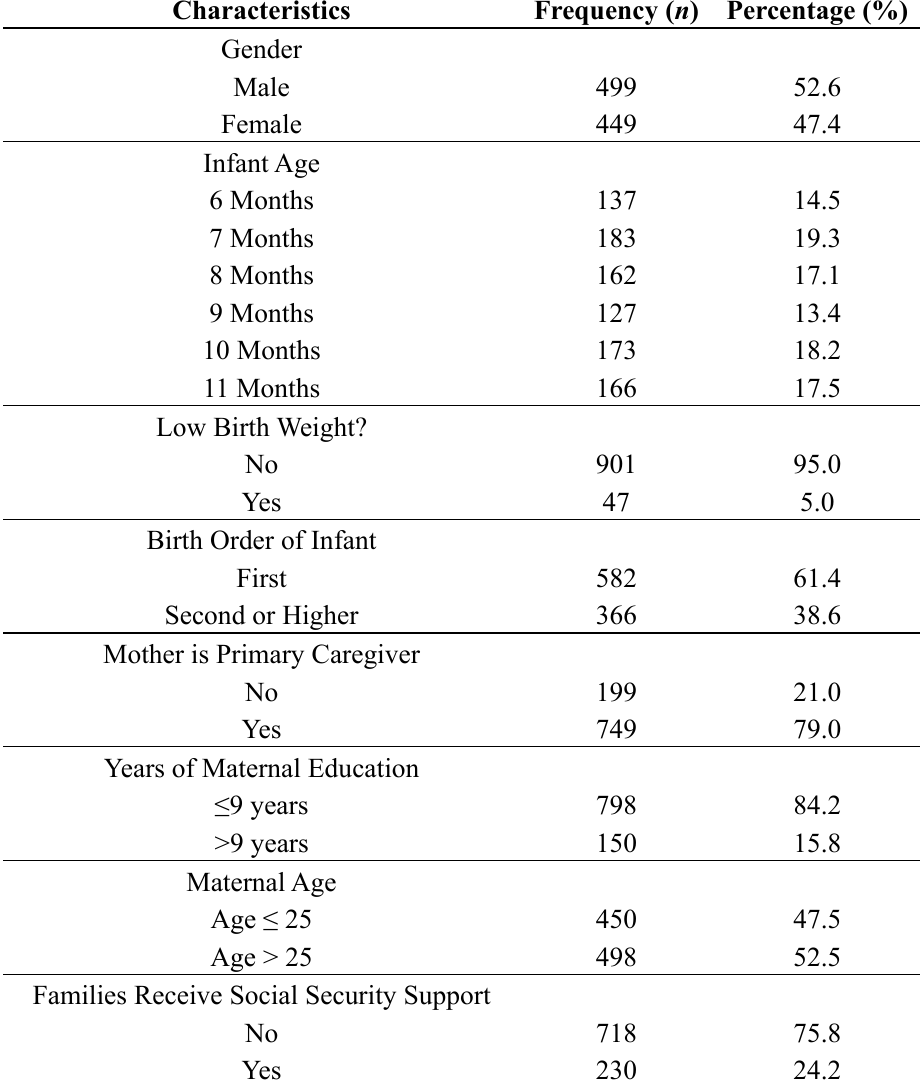
Table 1. Basic characteristics of sample infants in rural Shaanxi Province ( N =